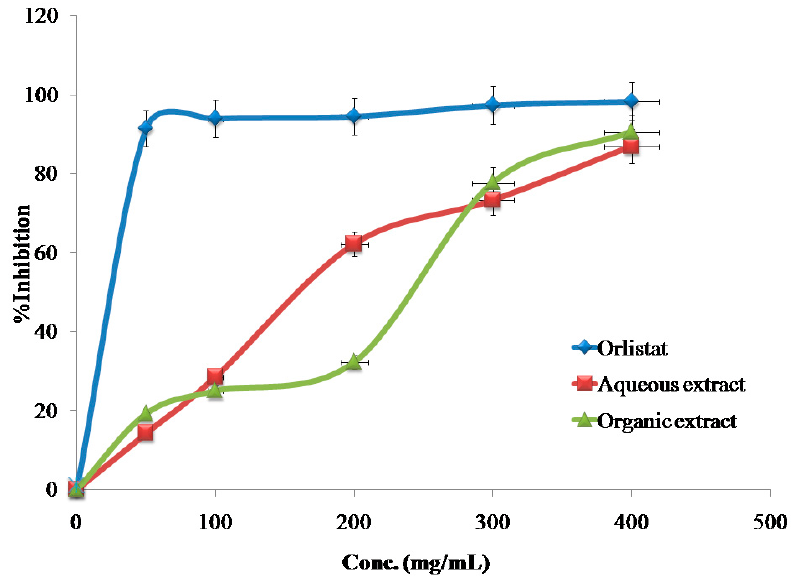
Figure 1. The inhibitory effects of the aqueous and organic extracts of A. palaestinum and Orlistat on the activity of porcine pancreatic lipase.